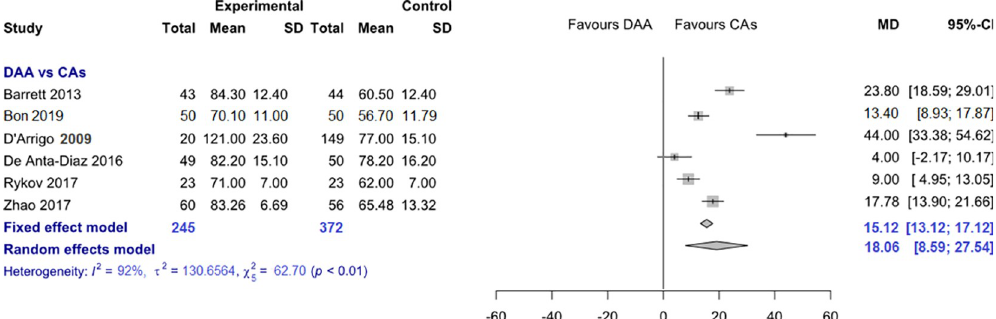
Fig 2. Comparison of the operation time in min. DAA, direct anterior approach; CAs, conventional approaches; SD, standard deviation; MD, mean difference; CI, confidence interval.